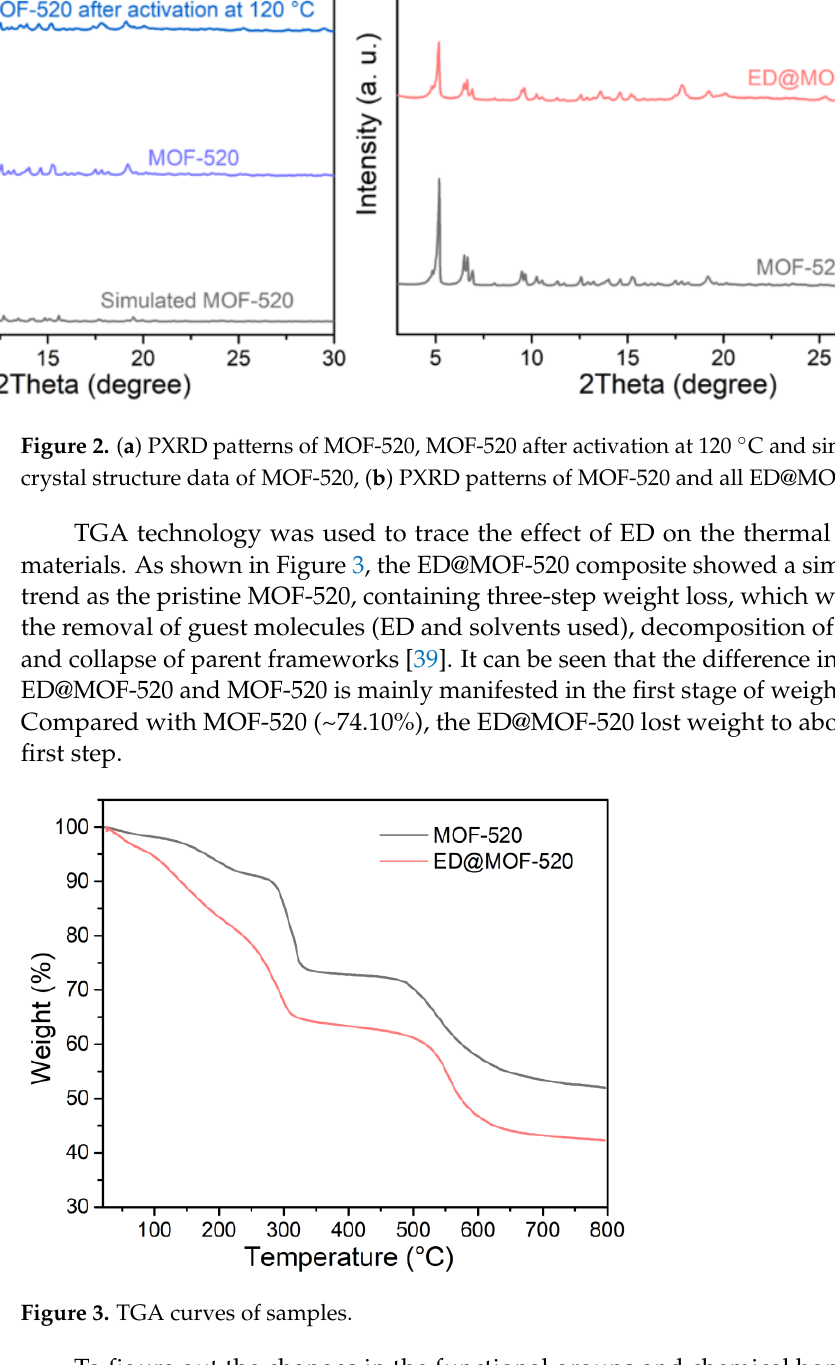
Figure 3. TGA curves of samples.